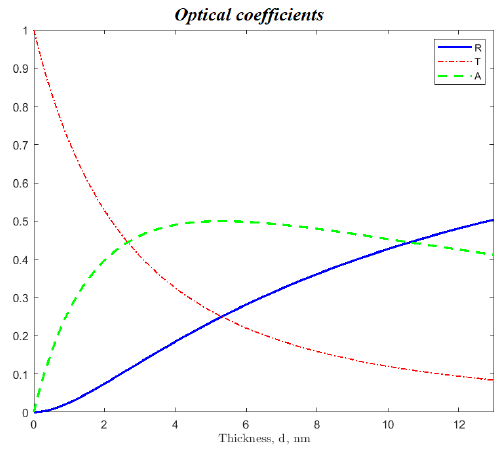
Fig. 1. Optical coefficients dependence on the film thickness obtained by 1D model